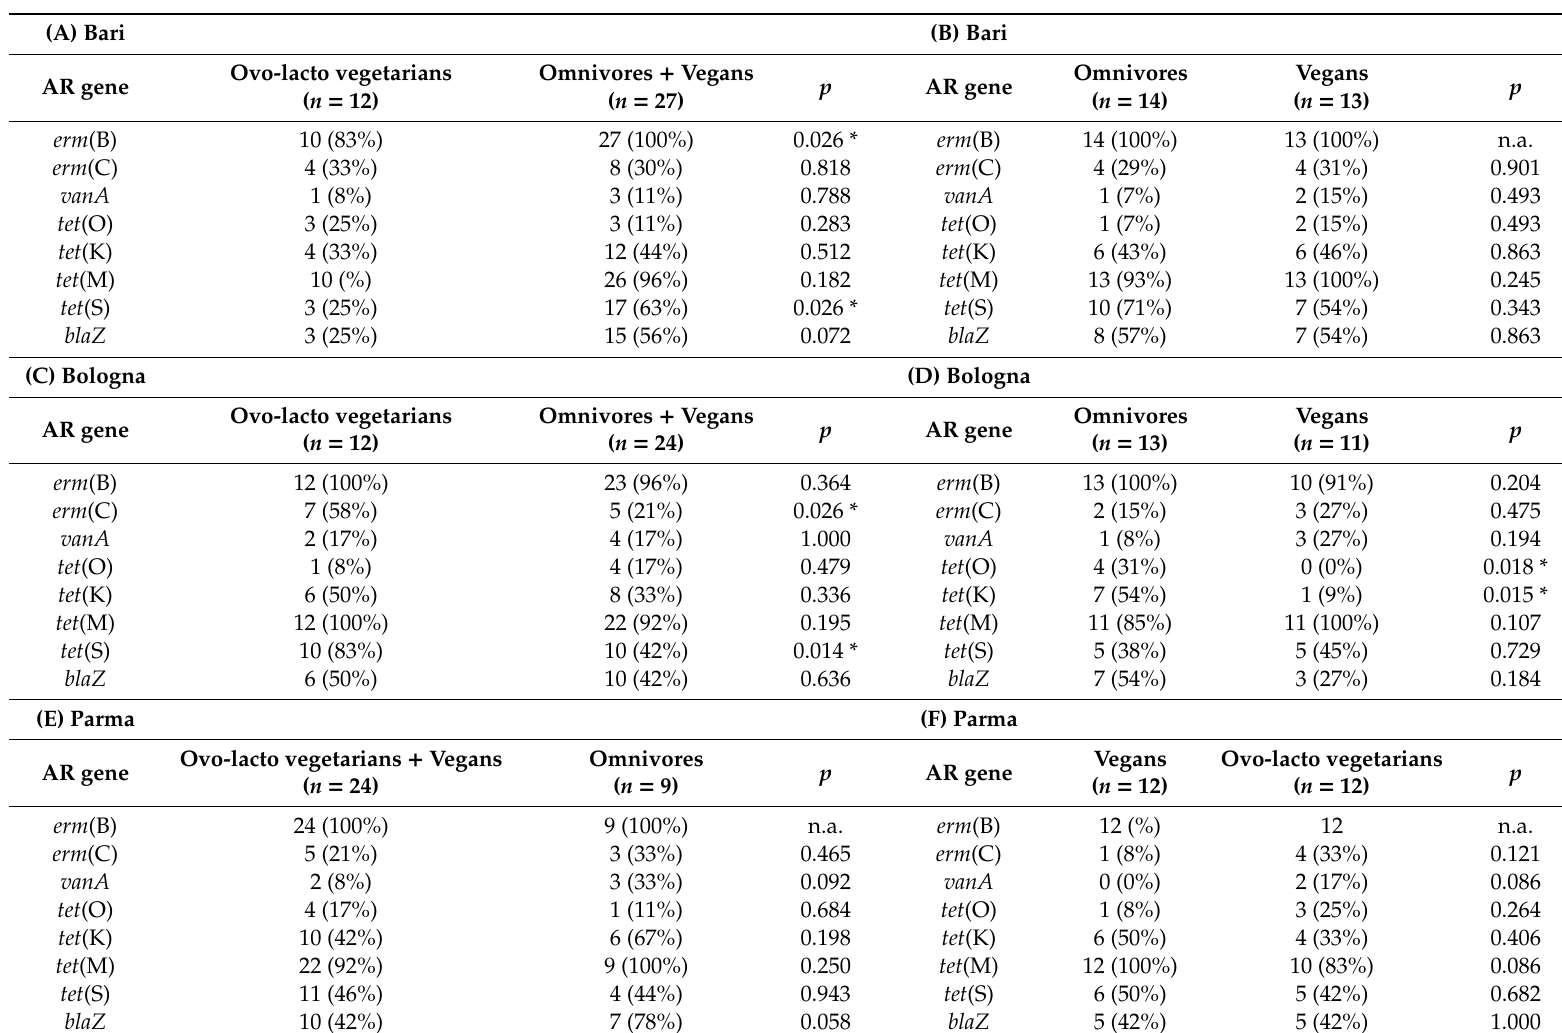
Table 3. Results of orthogonal contrasts between dietary habits within each recruiting